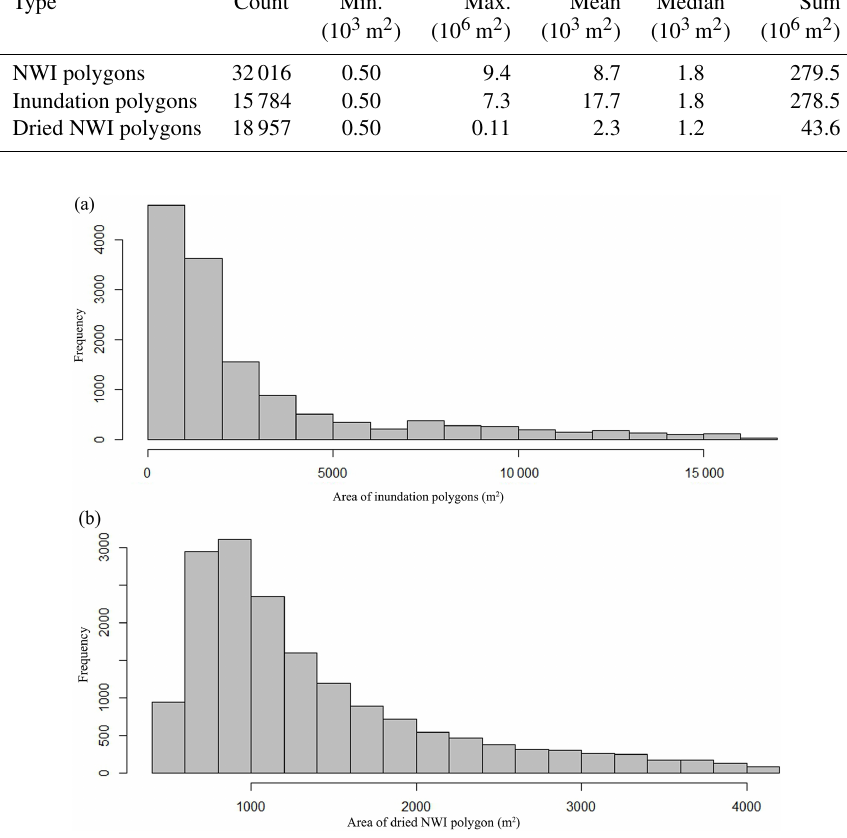
Figure 5. Histograms of inundation and NWI wetland polygons. (a) Inundation objects derived from lidar intensity data; (b) dried NWI wetland polygons not intersecting inundation